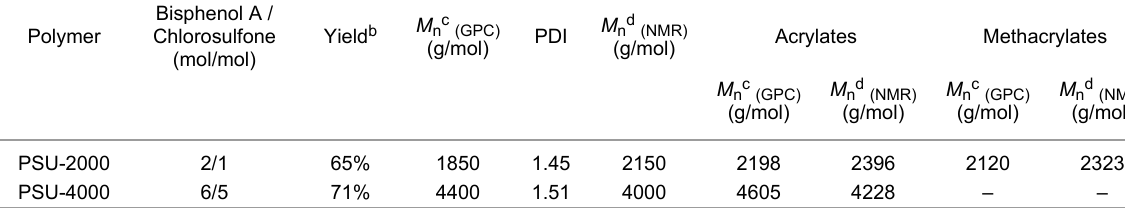
Figure 1: FT-IR spectra of PSU-2000, PSU-DA-2000 and PSU-DM- 2000.